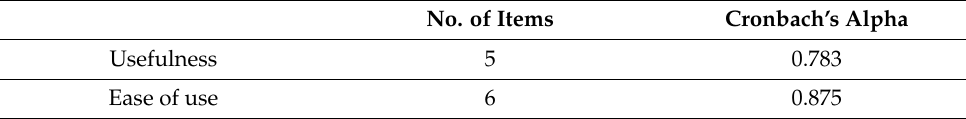
Table 5. Reliability analysis.